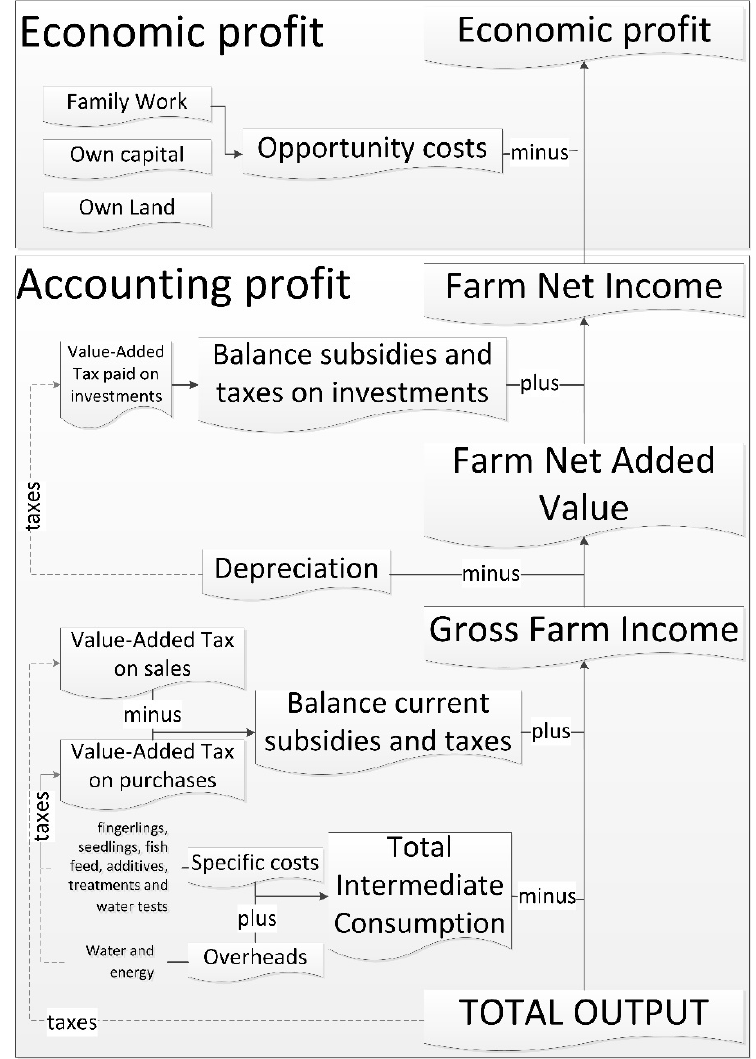
Figure 2. Diagram of the farm accountancy data network (FADN) methodology employed for the cost-benefit analysis.